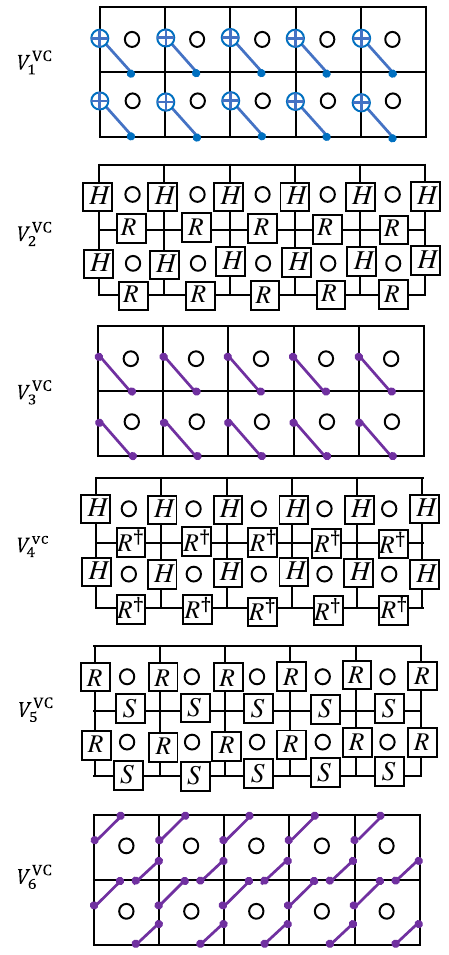
FIG. 13. The finite-depth Clifford circuit to convert the Verstraete-Cirac mapping to the exact bosonization. Details of the H , R , S gates are discussed in Appendix B. The finite-depth Clifford circuit that converts the Verstraete-Cirac mapping